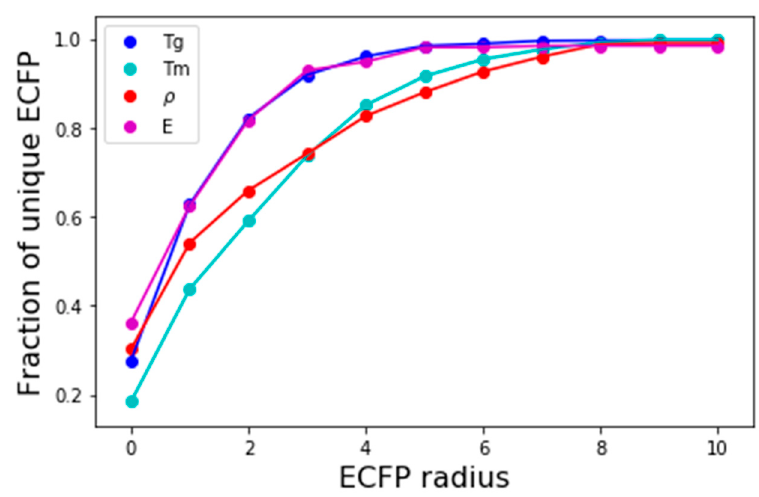
Figure 4. Comparison of the fraction of polyamides uniquely represented by varying the radius of ECFP in dataset for each of the property. Beyond ECFP 8, the value all polyamides can be distinctly represented.